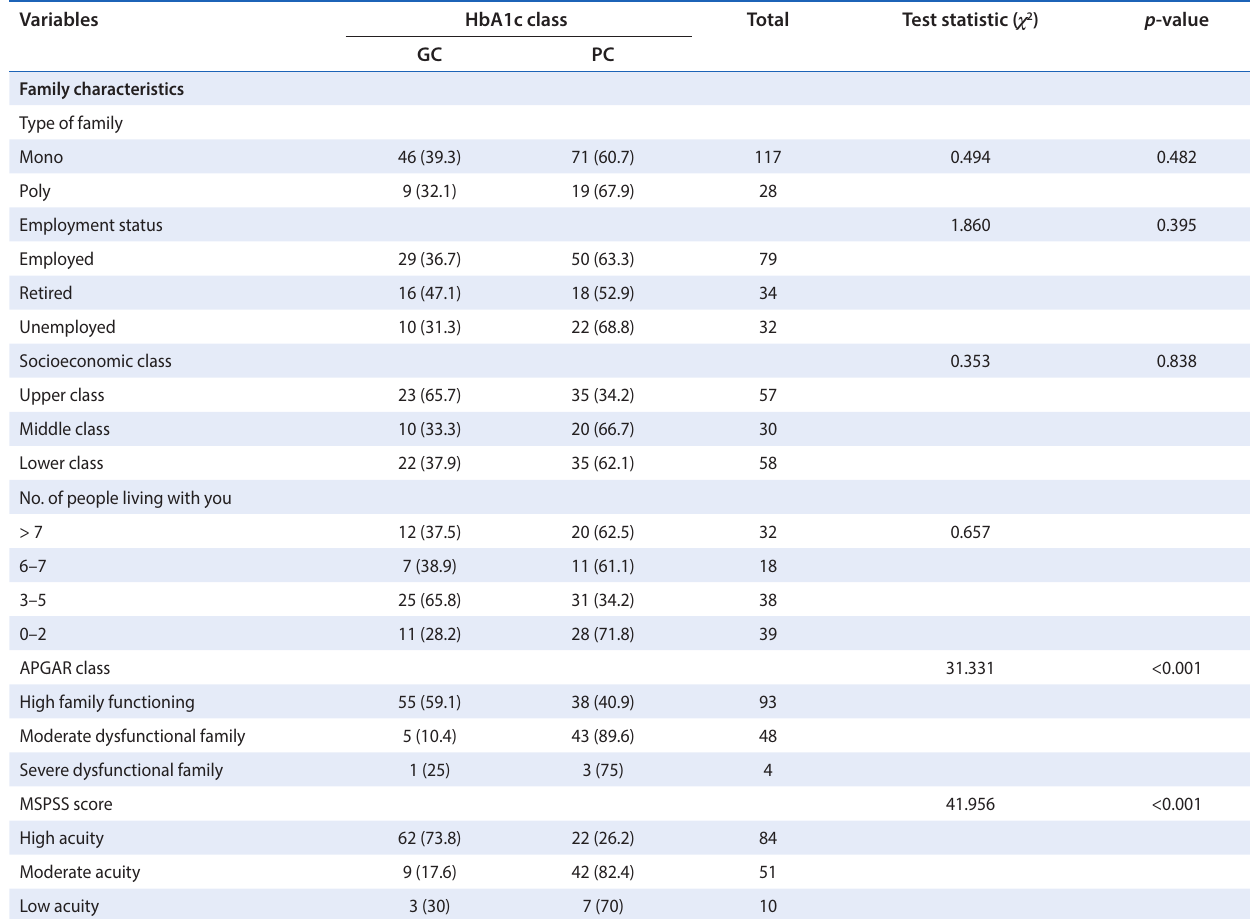
Table 4: Relationship between family characteristics and type 2 diabetes